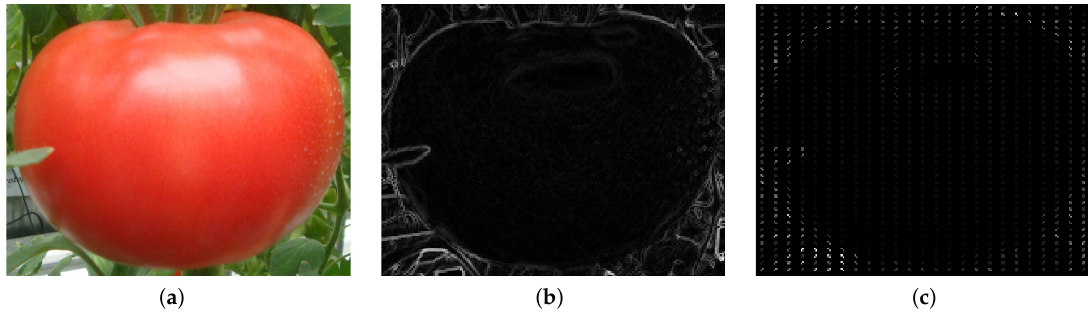
Figure 1. An example of Histograms of Oriented Gradients (HOG) descriptors: ( a ) An original sample, ( b ) the magnitude of the gradient image, and ( c ) a visualization of the HOG descriptors.